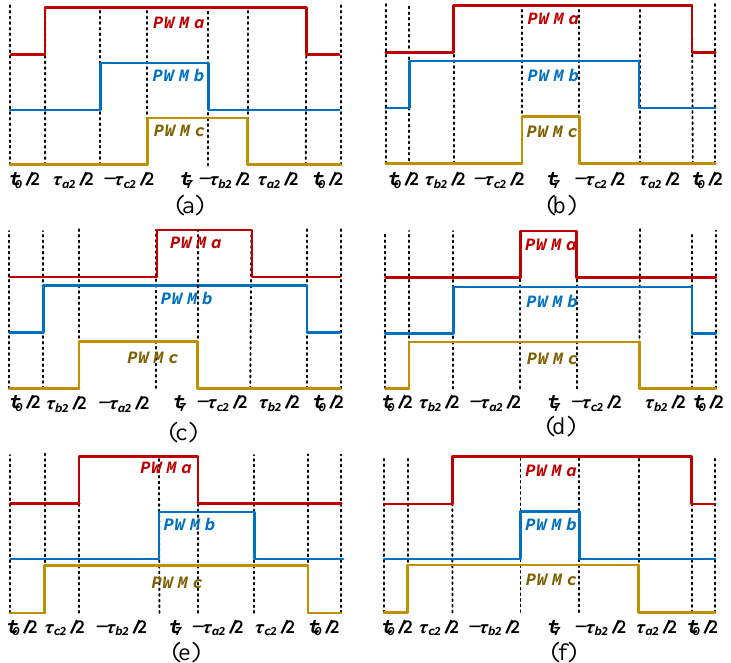
Figure 7. The phase-shift PWM signal: ( a ) case 1: τ a 2 > 0, τ b 2 < 0, and τ c 2 ≤ 0, ( b ) case 2: τ a 2 > 0, τ b 2 > 0, and τ c 2 ≤ 0, ( c ) case 3: τ a 2 ≤ 0, τ b 2 > 0, and τ c 2 < 0, ( d ) case 4: τ a 2 ≤ 0, τ b 2 > 0, and τ c 2 > 0,